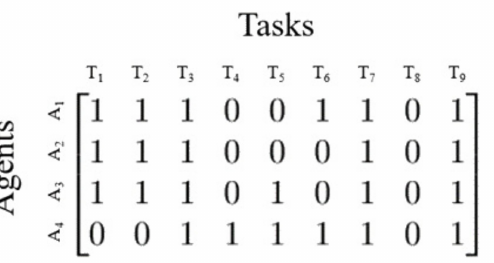
Figure 15. Existing Capability Matrix (ECM) for the example